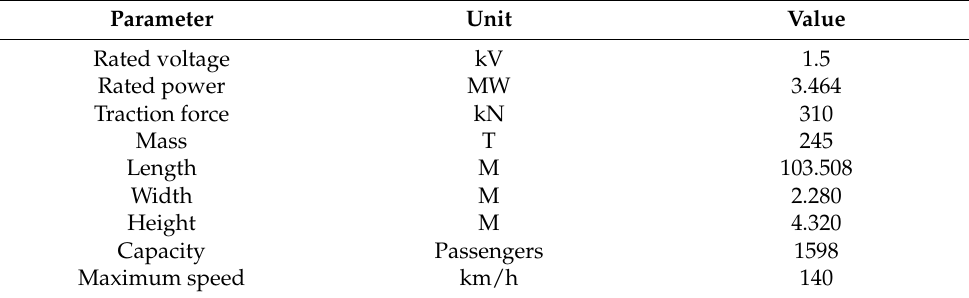
Table 3. Electric and geometric parameters of the trains.